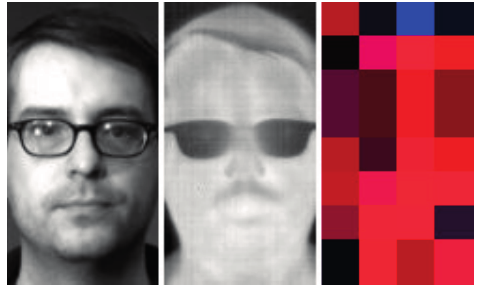
Figure 7. Optimal genetic code obtained for the